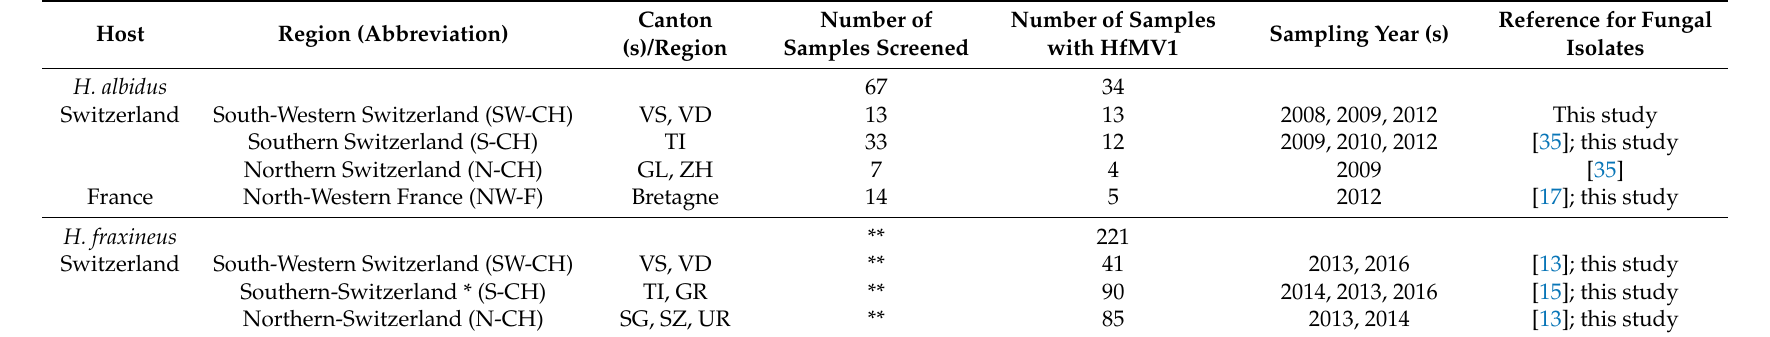
Table 1. Overview of the Hymenoscyphus albidus and H. fraxineus isolates included in the present